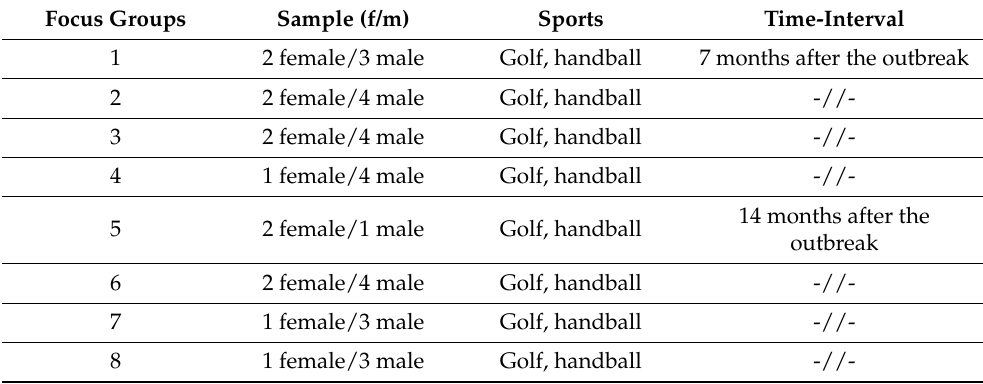
Table 1. Characteristics of the